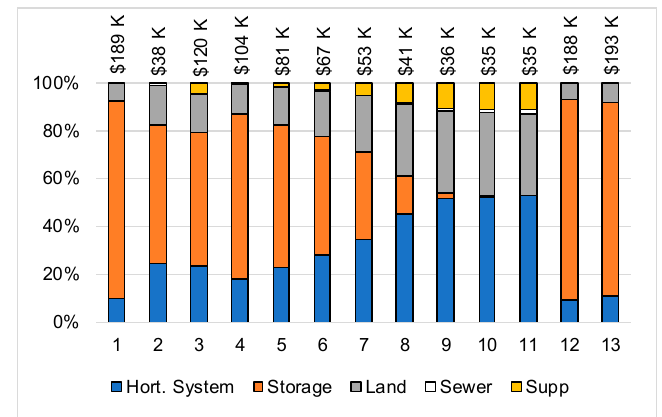
Figure 8. Capital expenditure breakdown for soil-based system in field conditions (SOIL-FIELD) in Parafield climate (K = ‘000).